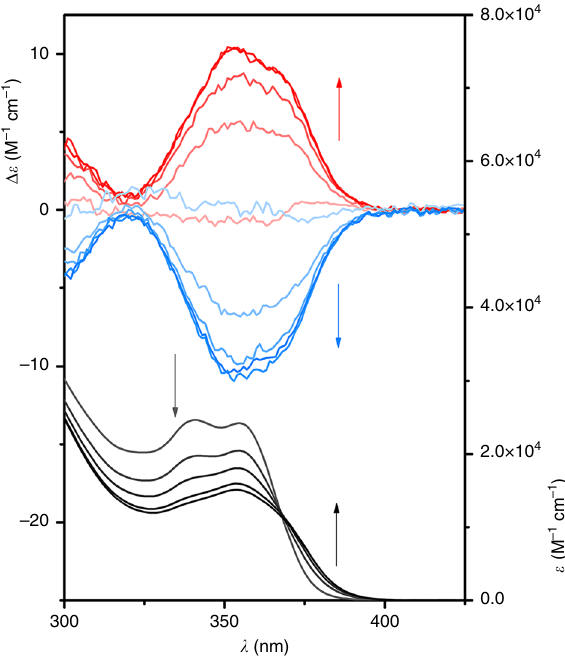
Fig. 4 Photochemically induced isomerisation. CD (top) and UV – vis (bottom) spectral changes upon irradiation for 0, 10, 20, 40 and 60 s with λ = 365 nm light of a mixture of ( E )- 2 (5.0 × 10 ‒ 4 M solution in CH max 25 °C) and either 2 equiv. [Bu 4 N] + [( S )- 3 ] ‒ (CD, red line) or [Bu 4 N] + [( R )- 3 ] ‒ (CD, blue line). The appearance of a CD signal upon irradiation is caused by photogenerated formation of ( Z )- 2 and simultaneous